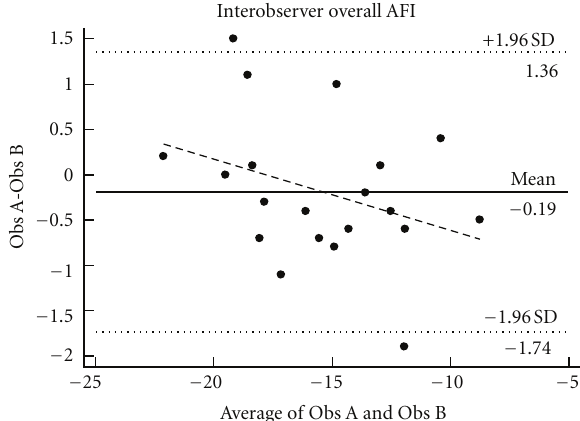
Figure 4: Bland Altman plots comparing observer A with observer B using AFI.